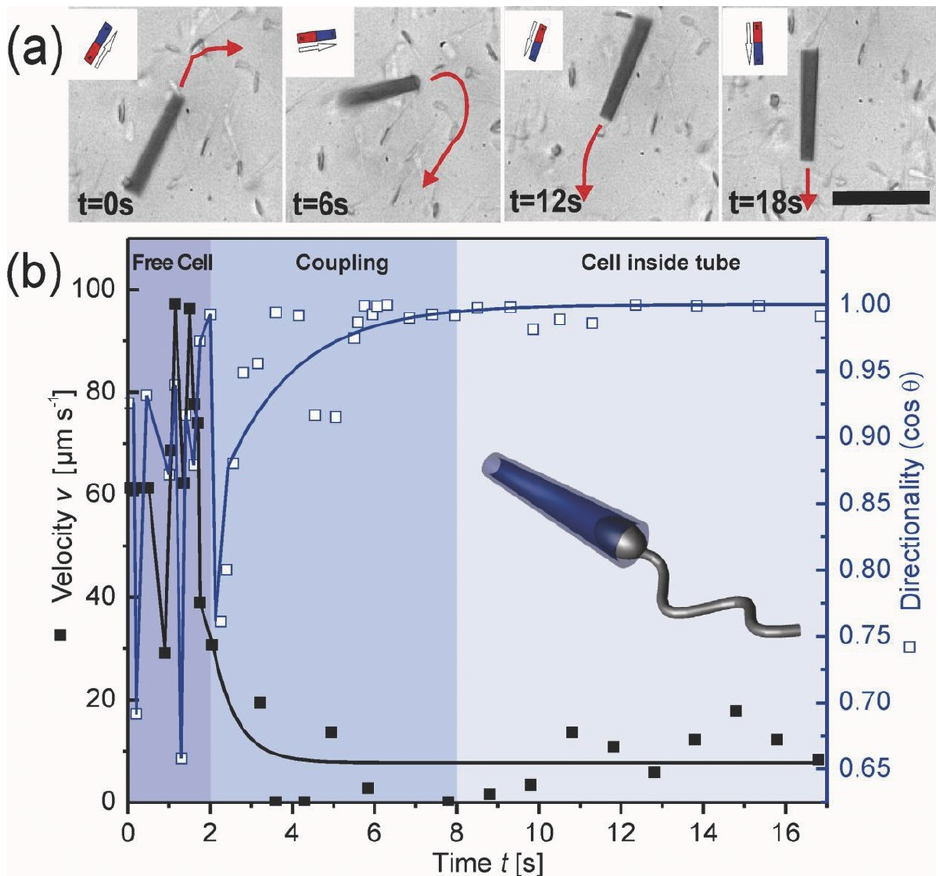
Figure 4. ( a ) Control of magnetic microtube containing a trapped sperm cell by external permanent magnet. Red arrows show moving direction. Scale bar 50 µ m. ( b ) Speed (left y-axis, black dots) and directionality (right y-axis, white squares) over the time of coupling process of the sperm cell with the microtube into a spermbot. (Reprinted from Reference [27] with permission from John Wiley & Sons, Inc.).